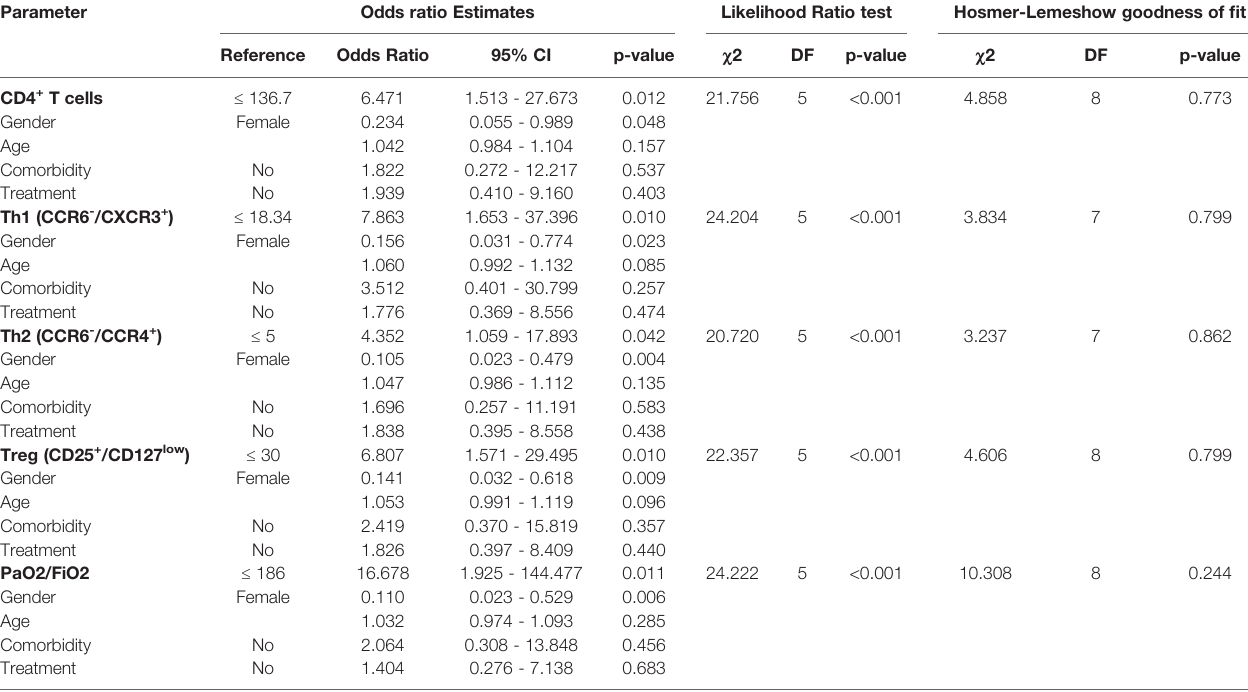
TABLE 4 | Multivariable logistic regression analysis for the prediction of a clinical aggravation during hospitalisation. Parameter Odds ratio Estimates Likelihood Ratio